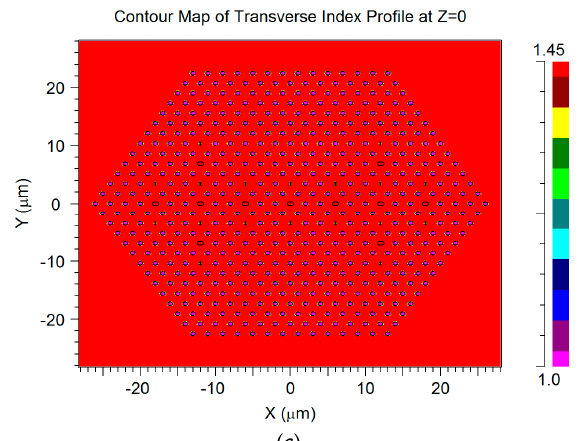
Figure 3. Refractive index profiles of the 8 × 1 power combiner: ( a ) xz plane at y = 0; ( b ) yz plane at x = 0; ( c ) xy plane at z = 0.